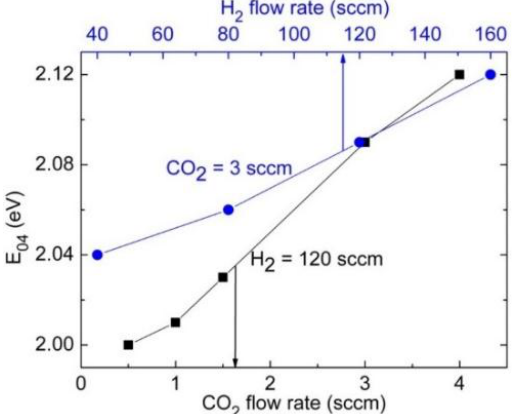
Figure 1. Bandgap evolution for two sample series: variable CO 2 flow rate at H 2 = 120 sccm (black symbols, bottom axis) and variable H 2 flow rate at CO 2 = 3 sccm (blue symbols, top axis).